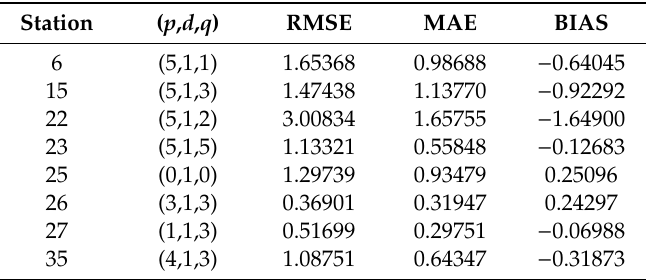
Table 7. RMSE, MAE and bias values in each station for ARIMA ( p , d , q ) models (RMSE: root mean squared error, MAE: mean absolute error, BIAS: bias or historial average error, ARIMA: autoregressive integrated moving average).